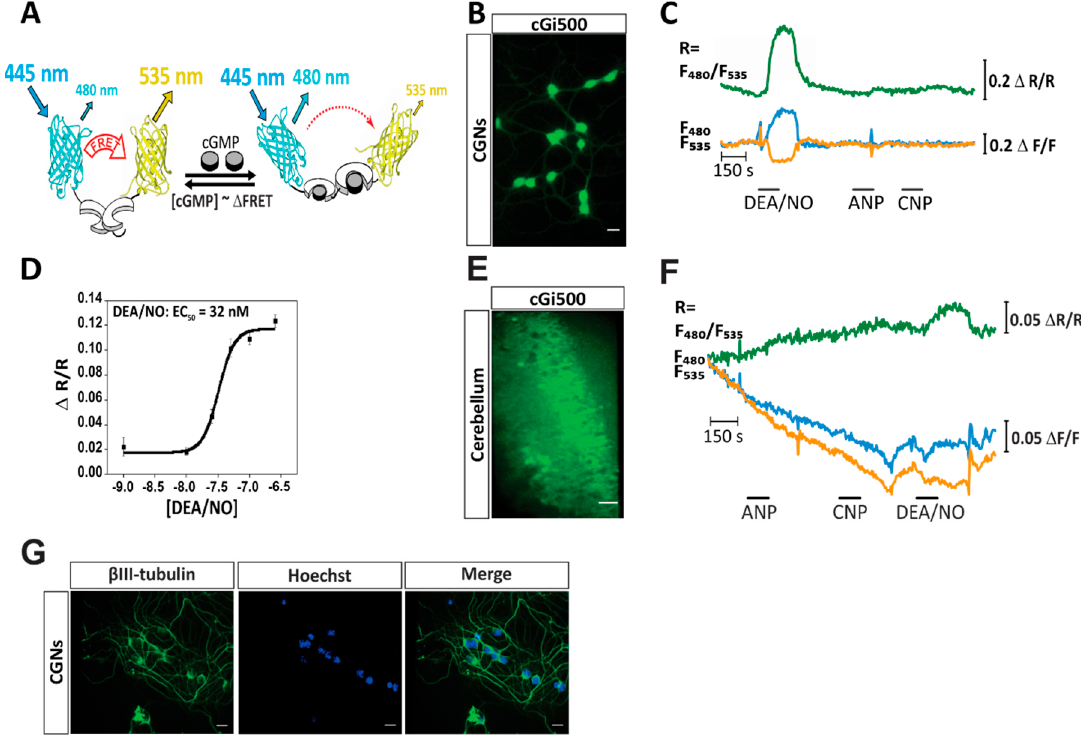
Figure 1. Visualization of cGMP in CGNs and acute cerebellar slices revealed a NO-induced cGMP response. ( A ) The cGi500 sensor consisted of cGMP-binding sites of the bovine cGKI (white) flanked by CFP (cyan) and YFP (yellow). Upon binding of cGMP (grey) a conformational change and a concomitant decrease in FRET efficiency occurred. Thus, upon excitation of CFP at 445 nm, light emission from YFP (535 nm) was reduced and emission from CFP (480 nm) was increased resulting in an increase of the CFP/YFP emission ratio when cGMP concentrations rise. Adapted from Reference [27]. ( B ) CGNs isolated from 7-day-old R26-CAG-cGi500(L1) mice expressed the cGi500 sensor (green). The green color represents the YFP fluorescence of cGi500. Scale bar 10 µ m. ( C ) cGMP measurement in CGNs upon stimulation with DEA/NO (100 nM), ANP (100 nM), and CNP (100 nM). Green, cyan, and orange traces represent CFP/YFP ratio, CFP emission, and YFP emission, respectively. Scale bars represent the change in fluorescence of the single fluorophores CFP or YFP ( ∆ F/F) or their ratio (CFP/YFP; ∆ R/R reflecting [cGMP]). The signals are from a single cell representative of the data set ( n = 57 cells measured on six coverslips obtained from three independent cultures). ( D ) Increasing concentrations of DEA/NO were applied to CGNs to establish a concentration-response curve. The EC 50 of CGNs for DEA/NO was ≈ 32 nM. Data are presented as mean ± SEM ( n = 12 cells per data point; cells from one culture were measured on one coverslip). ( E ) Acute cerebellar slice isolated from a 7-week-old R26-CAG-cGi500(L1) mouse. The green color represents the YFP fluorescence of cGi500. Scale bar is 20 µ m. ( F ) cGMP measurement in the granule cell layer of a cerebellar slice upon stimulation with ANP (250 nM), CNP (250 nM), and DEA/NO (5 µ M). Green, cyan, and orange traces represent CFP/YFP ratio, CFP emission, and YFP emission, respectively. Scale bars represent the change in fluorescence of the single fluorophores CFP or YFP ( ∆ F/F) or their ratio (CFP/YFP; ∆ R/R reflecting [cGMP]). The signals are from a single region of interest representative of the data set ( n = 3 acute cerebellar slices analyzed in three independent experiments). ( G ) Representative picture of a CGN primary culture stained for β III -tubulin (neuronal marker, green) and nuclei with Hoechst dye (blue); an overlay of both channels is also shown (Merge). Scale bar is 10 µ